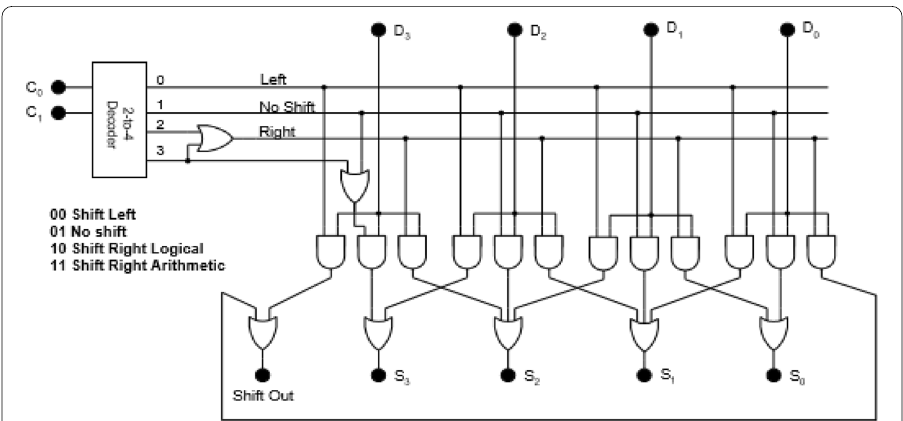
Fig. 3 A shifter that performs left shifts, logical and arithmetic right shifts, or no shift